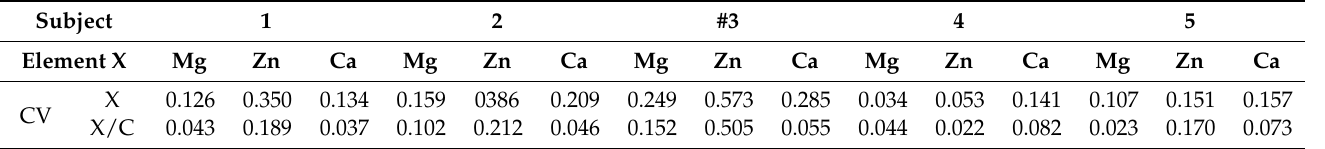
Table 2. Effect of normalization based on the peak intensity of C I at 247.8 nm. In the table, “X” and “X/C” show the coefficients of variations (CV) before and after normalization, respectively.